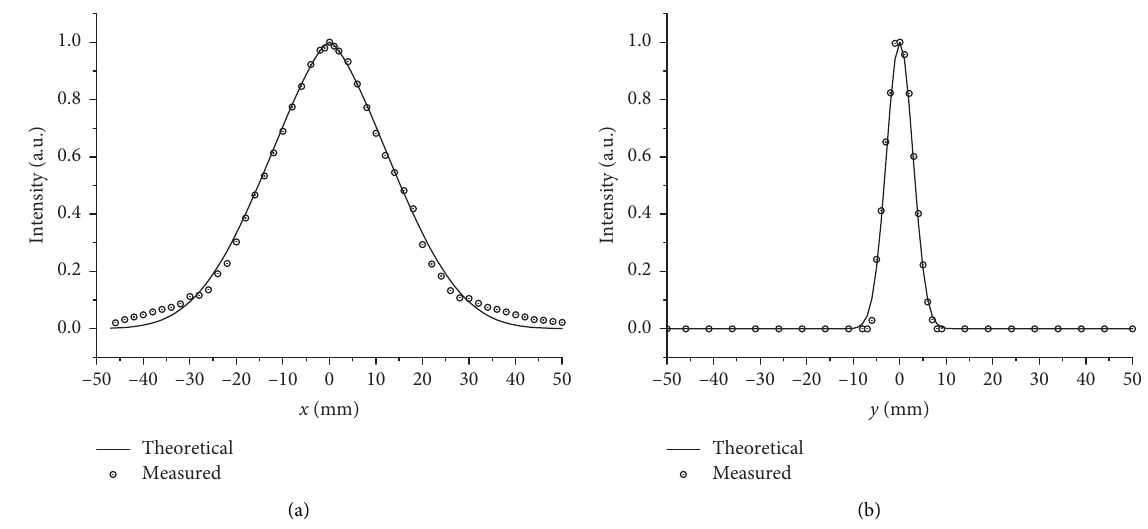
Figure 4: Measured and theoretical beam intensity profiles of TOLD9441MC. (a) x – z plane. (b) y – z plane.